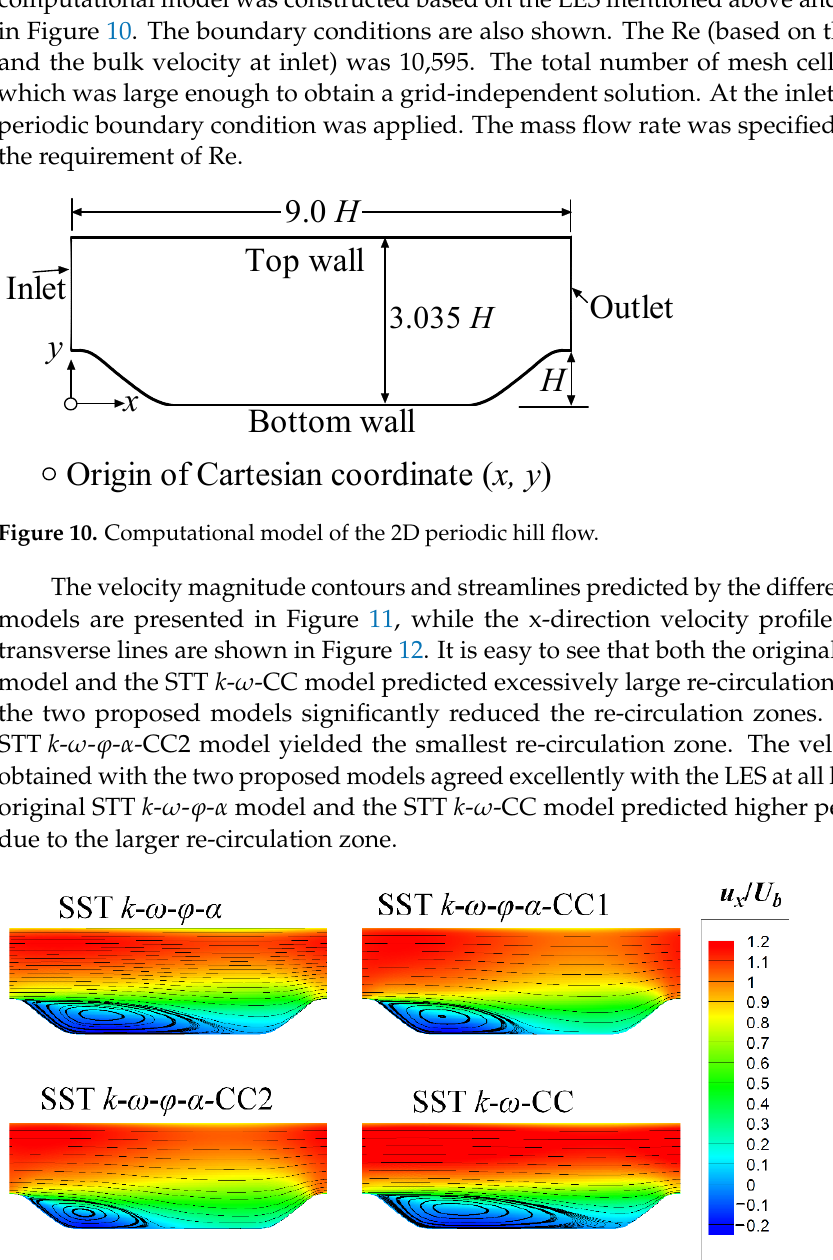
Figure 11. Velocity magnitude contours predicted by different turbulence models.